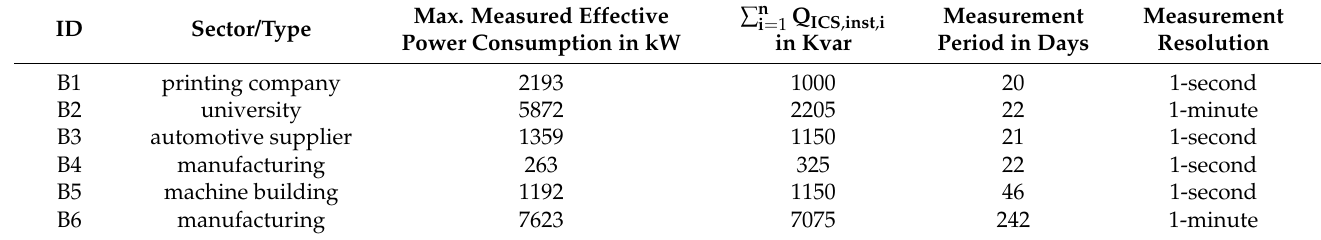
5 Table 2. Characteristic data of six measured industrial companies. ID